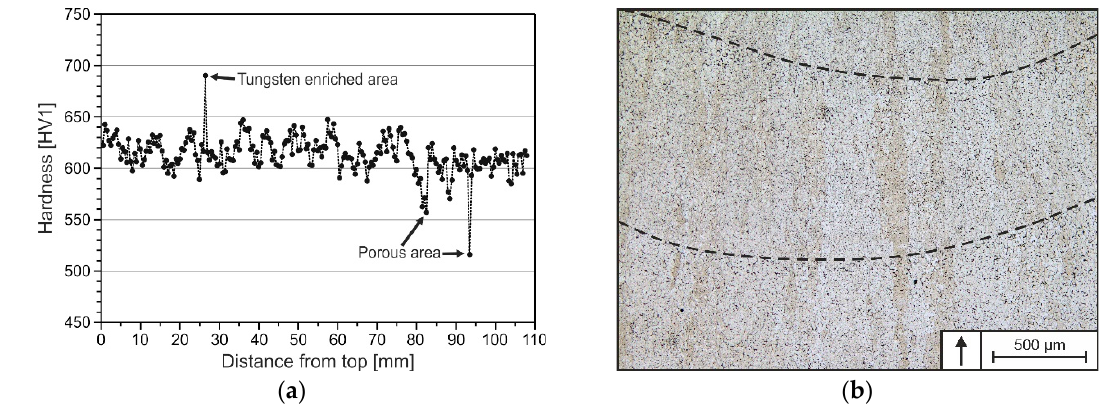
Figure 9. Hardness profile of tool steel X36 over built-up height ( a ) and exemplary picture of multiple HAZ due to continuous deposition ( b ). The fusion lines are indicated by dashed lines and the arrow marks the build-up direction.